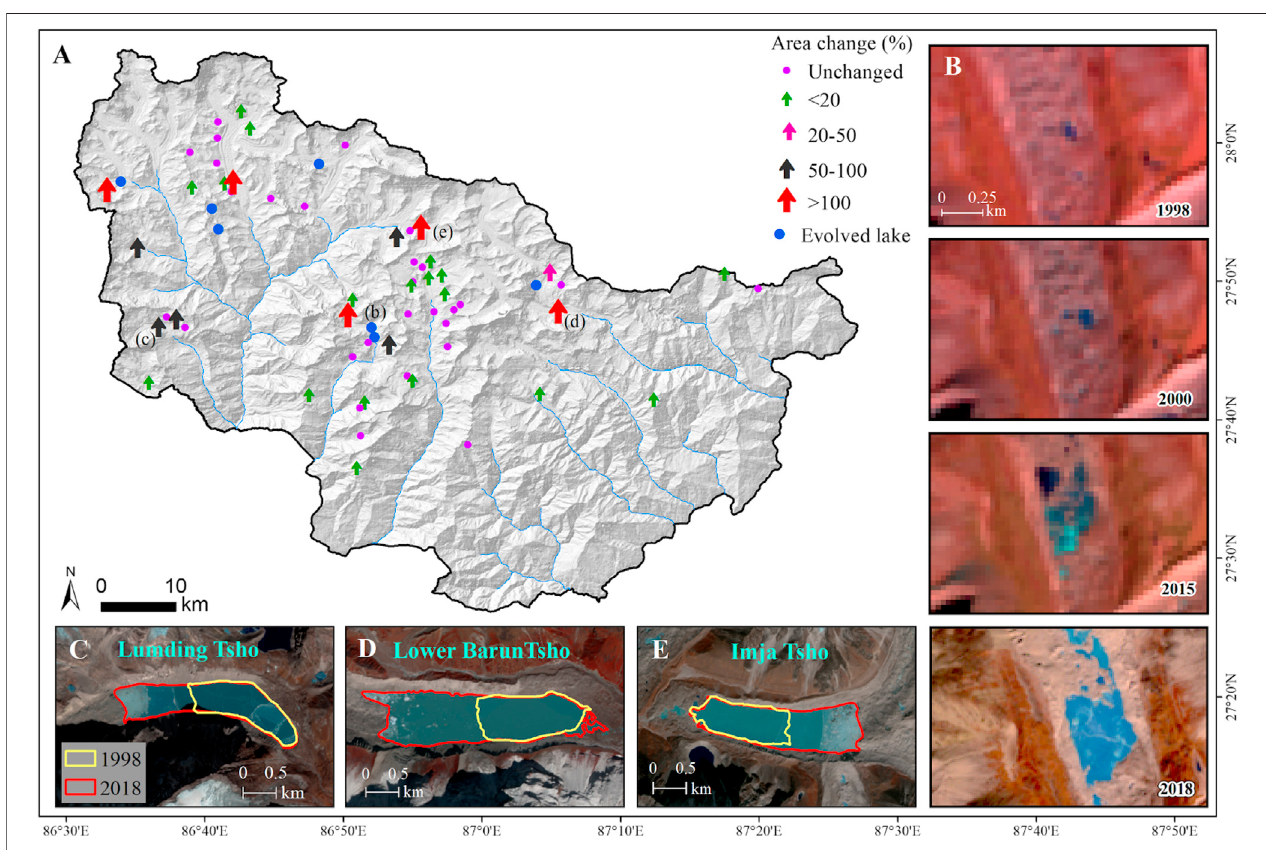
FIGURE 6 | Area change of glacial lakes > 0.05 km 2 (A) , the evolution of supraglacial lake (B) and expansion of proglacial lakes (C,D,E) between 1998 and 2018. Since different resolution images were used in 1998 and 2018, unchanged lakes were considered as those lakes in 1998 that did not exceed the lake area delineated in 2018 and did not reduce signi fi cantly.